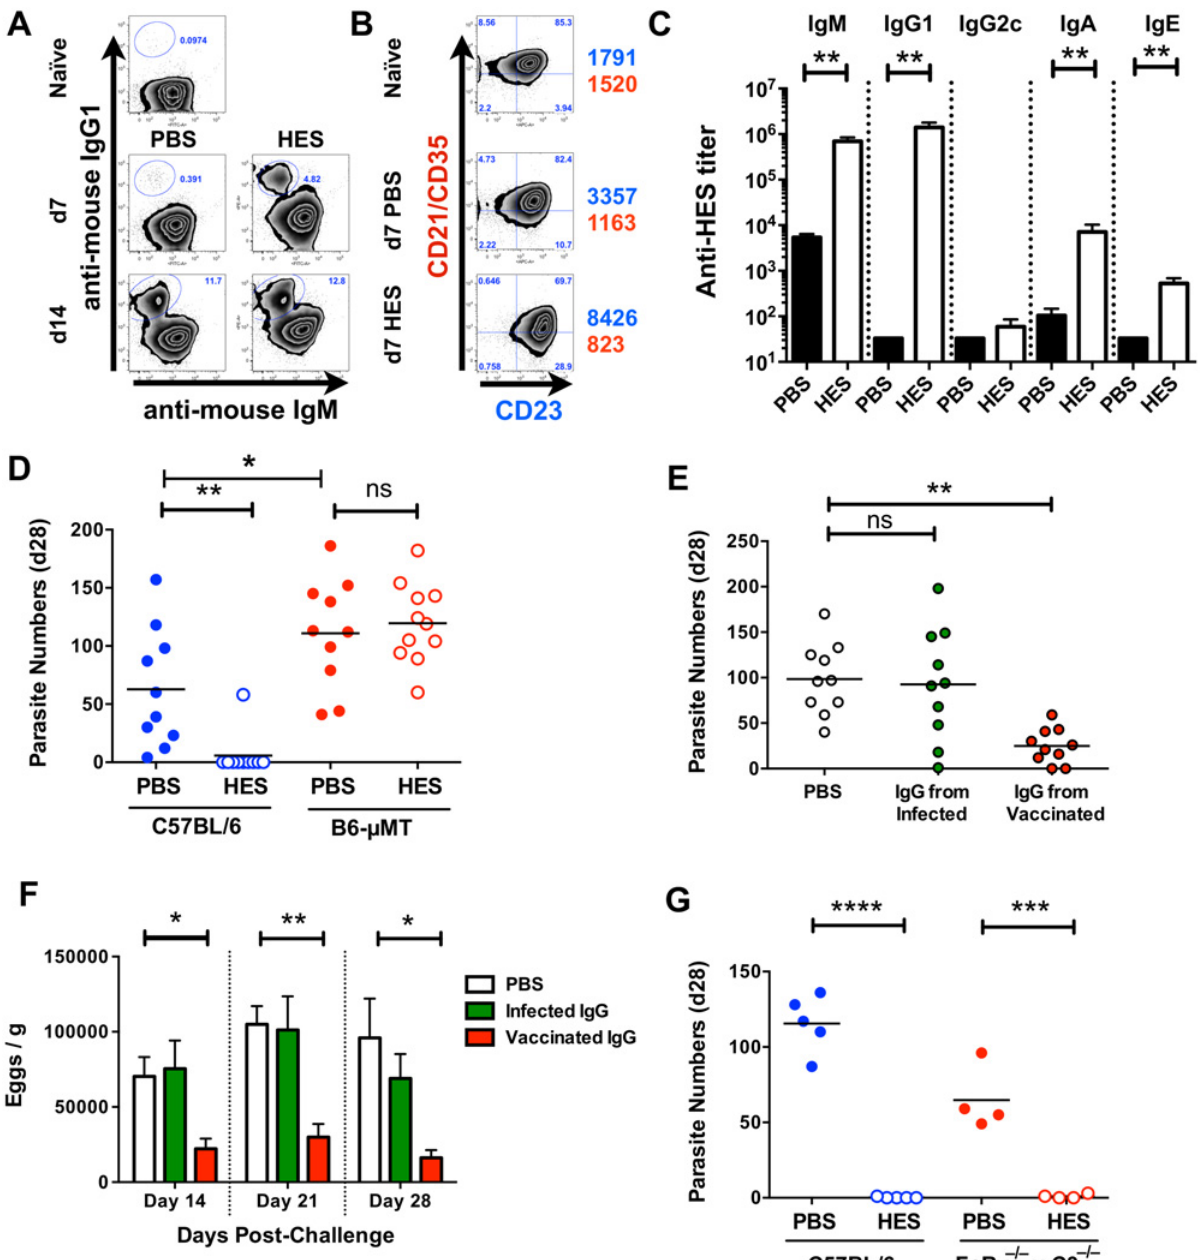
Fig 3. Immunity is dependent on cognate B cells and partially transferrable by antibody. A . Gated CD19 + MLN cell expression of cell surface IgM and IgG1 in na ï ve and d 7 and d 14 post-challenge PBS and HES B6 mice. B . Gated CD19 + MLN cell expression of cell surface CD21/CD35 (CR2/CR1) and CD23 (Fc ε RII) in na ï ve and d 7 post-challenge PBS and HES B6 mice. Numbers represent geoMFI of CD23 (blue) and CD21/CD35 (red) expression. A-B representative of two independent experiments with 3 – 5 mice per group. C . Pre-challenge anti-HES IgM, IgG1, IgG2c, IgA and IgE titers in PBS and HES vaccinated B6 mice with 5 mice per group. D . Day 28 post-challenge worm burdens from C57BL/6 and μ MT mice following HES immunization or PBS control. Data pooled from two experiments. Significance determined by ANOVA as indicated. E, F . Day 28 post-challenge worm and fecal egg burdens (d 14, 21, 28) in na ï ve C57BL/6 mice receiving IgG from vaccinated or primary infected mice, or PBS, as detailed in materials and methods. Data are pooled from two experiments, with significance determined by ANOVA Vs C57BL/6 PBS. G . Day 21 post-challenge adult worm burdens in C57BL/6 and FcR γ – / – x C3 – / – mice following HES immunization or PBS control. Significance determined by t -test as indicated. See also S2 Fig.